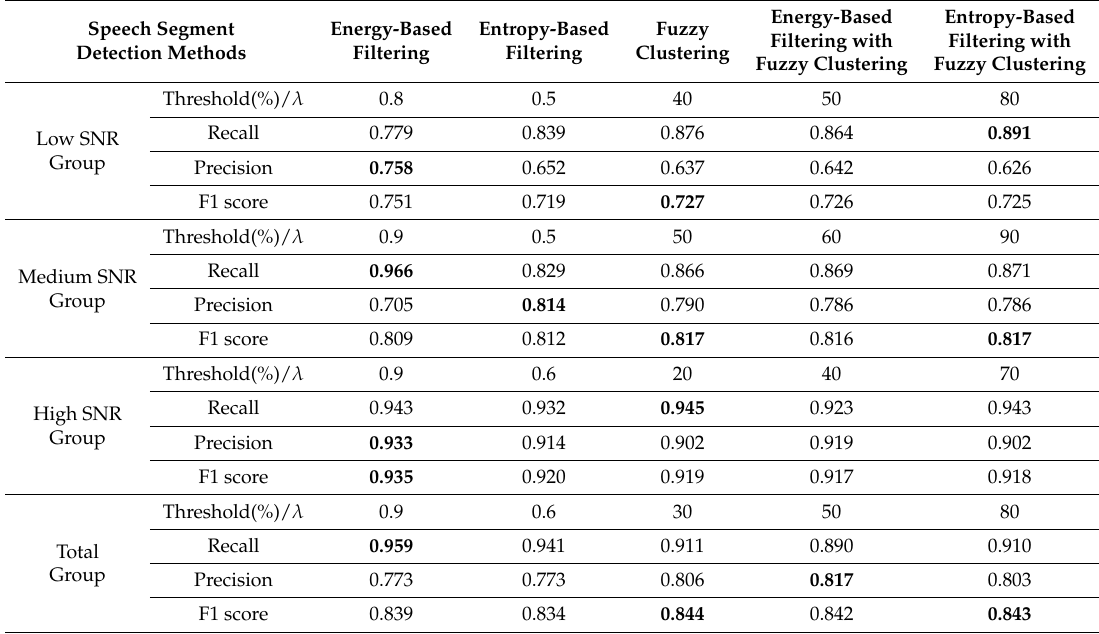
Table 2. The recall, precision, and F1 score by speech segment detection methods.